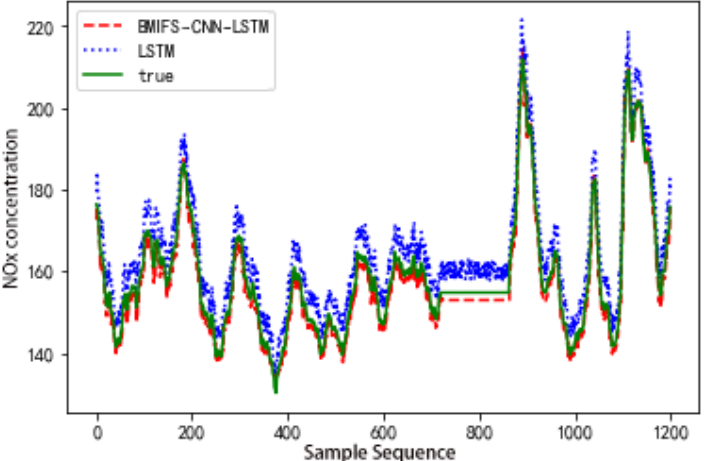
Figure 6. Comparison chart of training-data fitting effect.